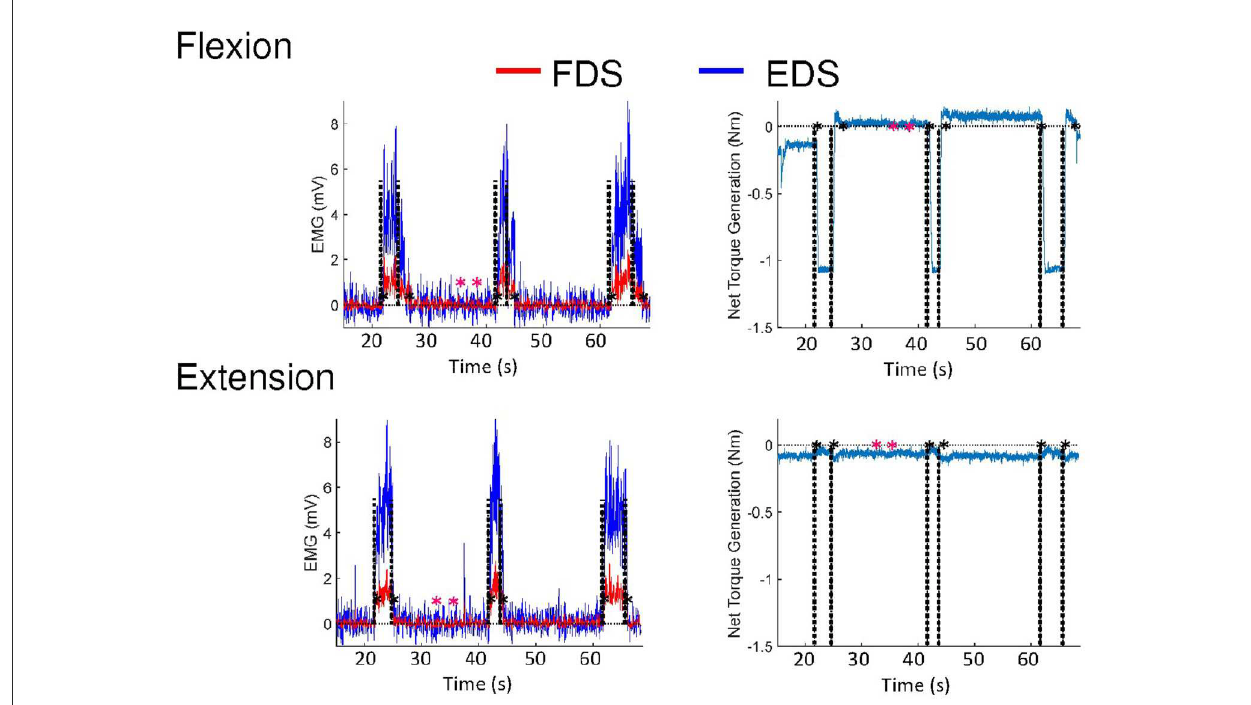
FIGURE1 EMG and torque responses of a representative subject during voluntary flexion and extension, respectively. Black dashed lines indicate the times points of auditory tones occurring. The black asterisks indicate the time points that are registered by responses of the subjects versus a predefined threshold. The predefined threshold (3 standard deviations above the mean of EMG during the rest period) is based on the rest period defined by the pink asterisks. The subject involuntarily contracted the MCP flexor so the torque at the beginning was not 0.